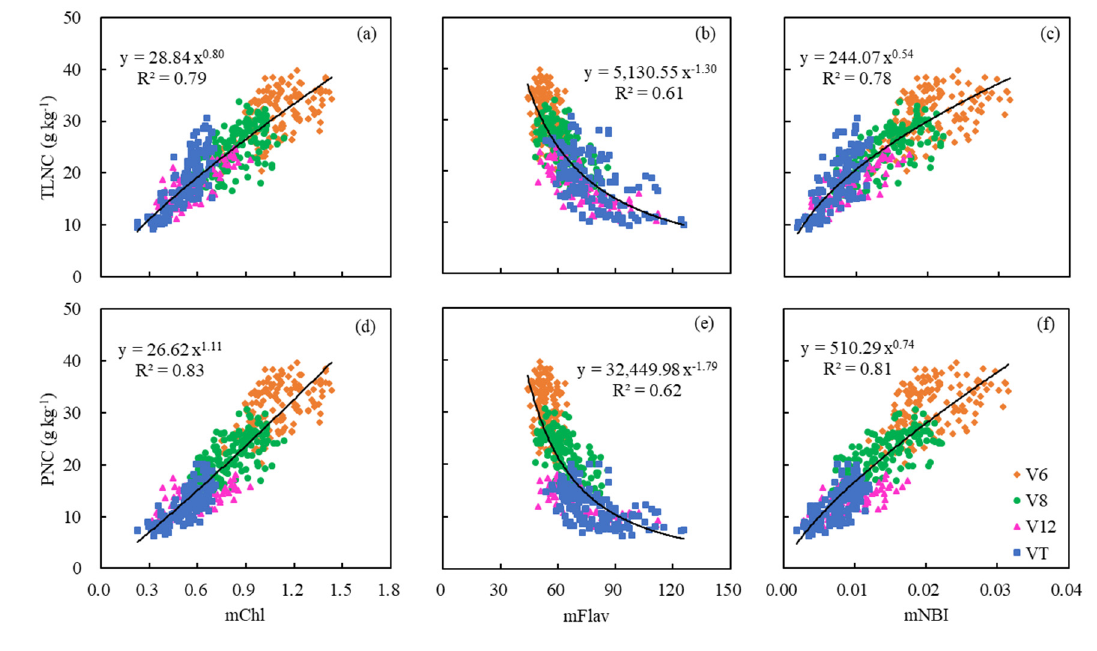
Figure 7. Relationships between modified Dualex 4 parameters (mChl, mFlav, and mNBI) for the mean values of three differently positioned leaves and two N status indicators (TLNC and PNC) across growth stages. 342 Table 4. Coefficients of determination (R 2 ) for the relationships between Dualex 4-based parameters 343 of three differently positioned leaves and two N status indicators (TLNC and PNC). 344